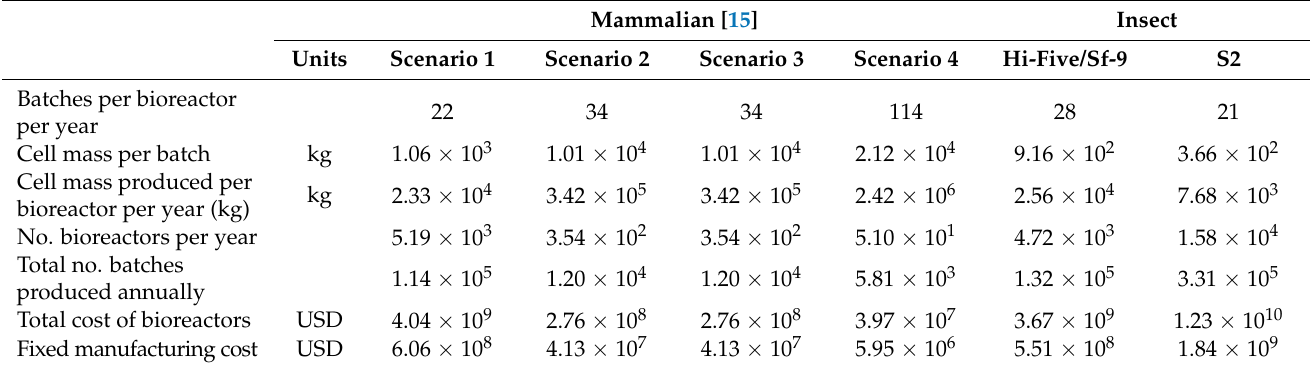
Table 3. Outcome values relating to bioreactors produced by the model for four mammalian scenarios proposed in the Risner et al. paper compared to baseline outcomes for Hi-Five/Sf-9 and S2 insect cells [15].